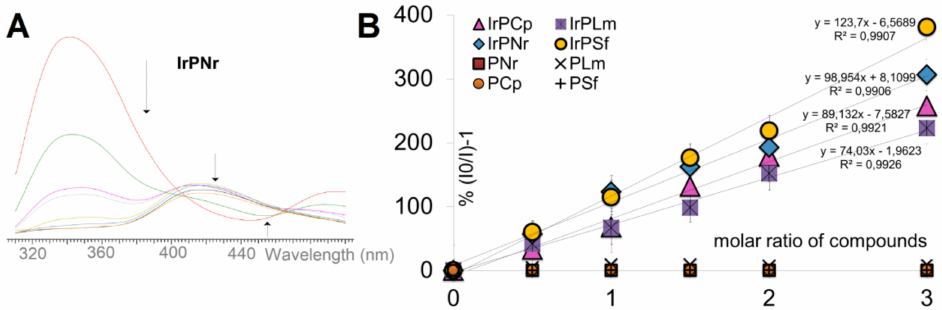
Figure 7. ( A ) Fluorescence quenching of HSA (C = 5 × 10 − 5 M) by IrPNr , (molar ratios 0.5, 1, 1.5, 2, 3, 4, 5, 6) in 50 mM pH 7.4 phosphate buffer; ( B ) Stern–Volmer plots of HSA (C = 10 µ M) quenching by PCp , PNr , PSf , PLm , IrPCp , IrPNr , IrPSf , IrPLm (I 0 and I—intensity of HSA in the absence and presence of the increasing amounts of the compounds,